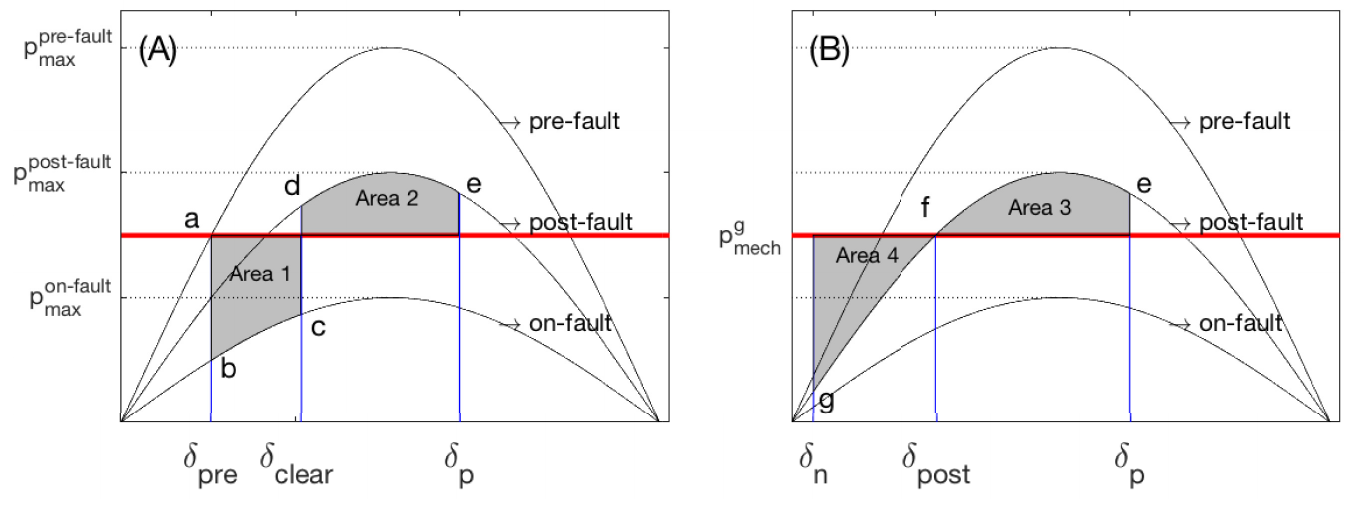
Fig 1. p- δ curve to illustrate the equal-area